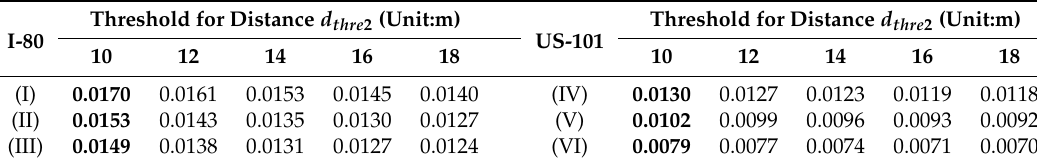
Table 5. Parameter comparison for distance d thre 2